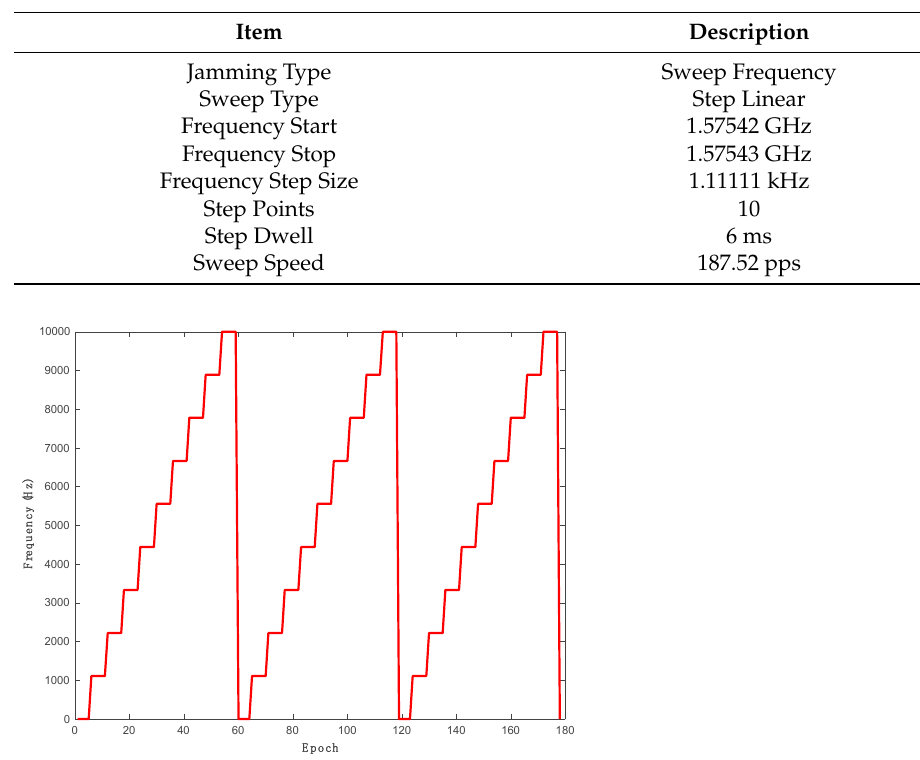
Figure 4. Step linear swept jamming signal.